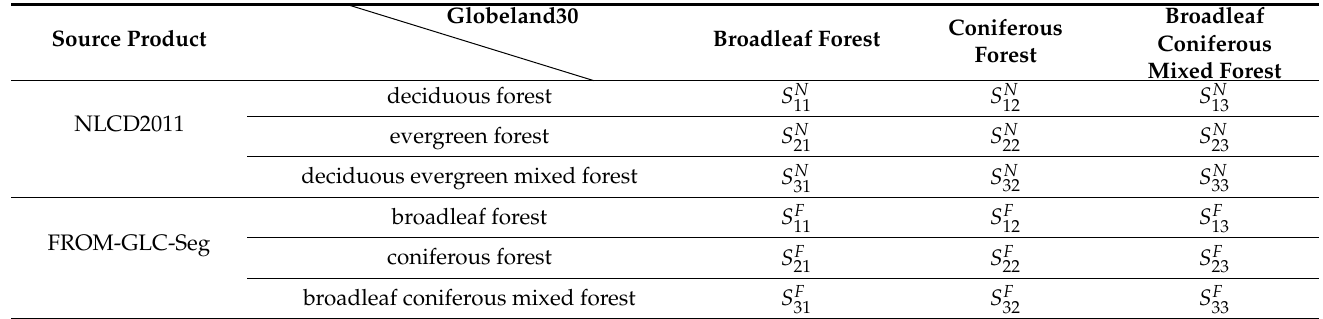
Table 1. Similarity